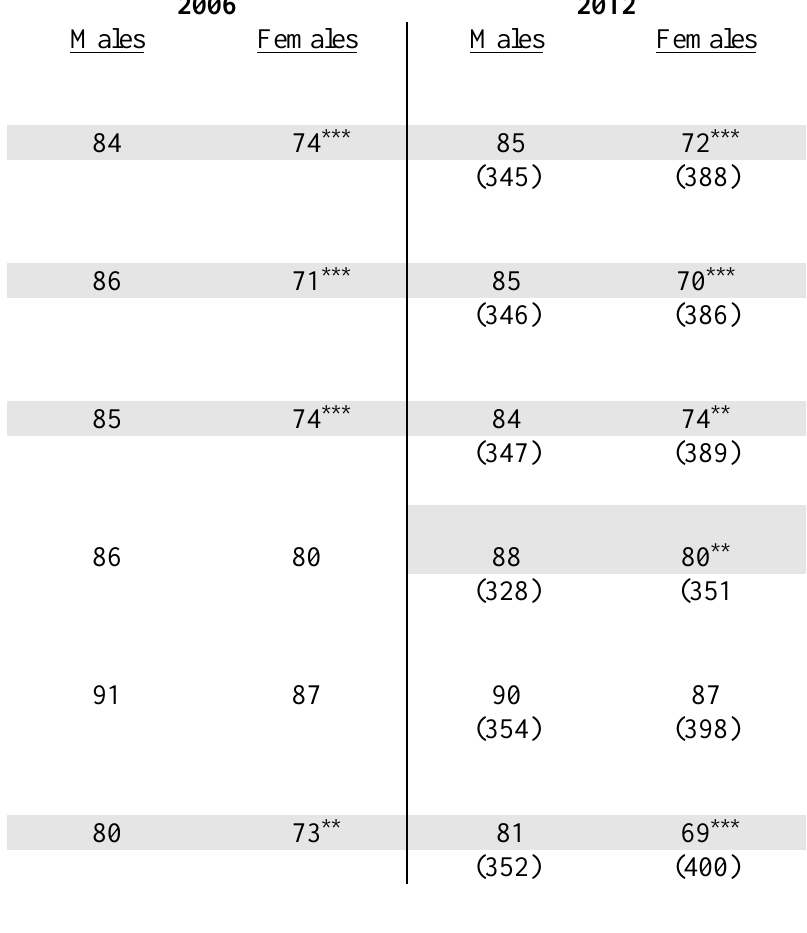
Table 29. Perception of Gender Equity (percent agreeing)